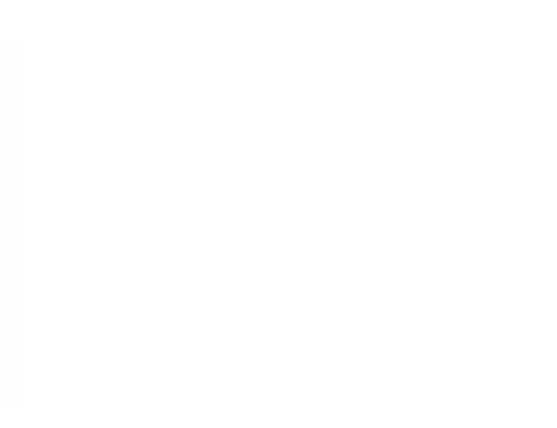
Figure 4. The relationship between the position distribution of the equivalent magnetic dipole and the equivalent error, when the magnetic moment ratio is 3:1.